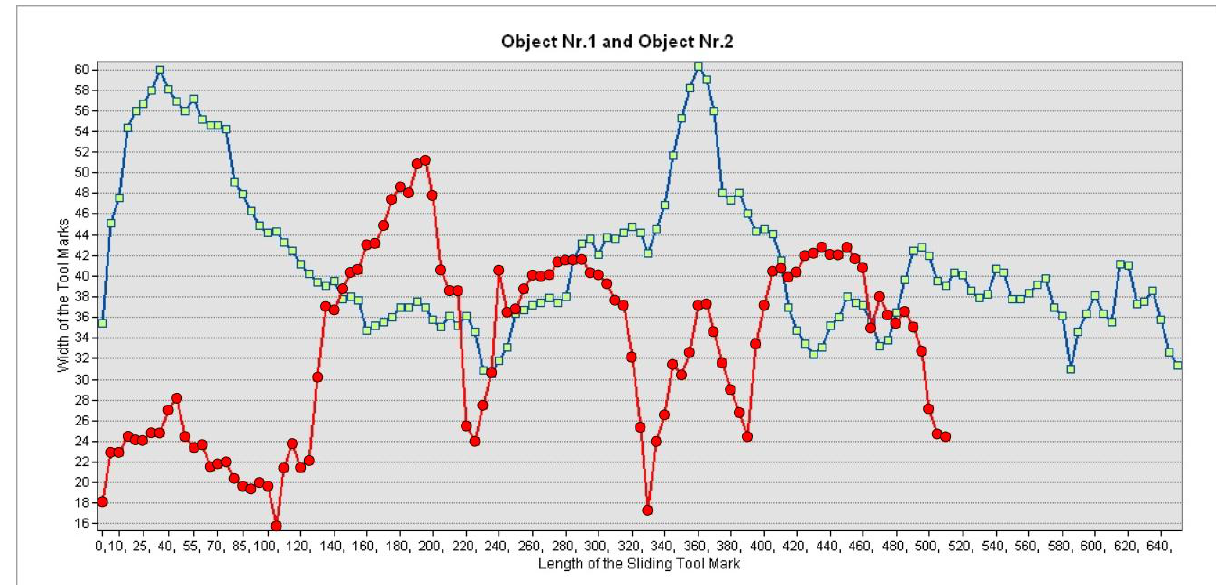
Figure 5. Spatial characterisation of the Bronze Age sliding tool marks - red line with circle markers: Object Nr.1; blue line with square markers: Object Nr.2 (the width and the length parameters are in